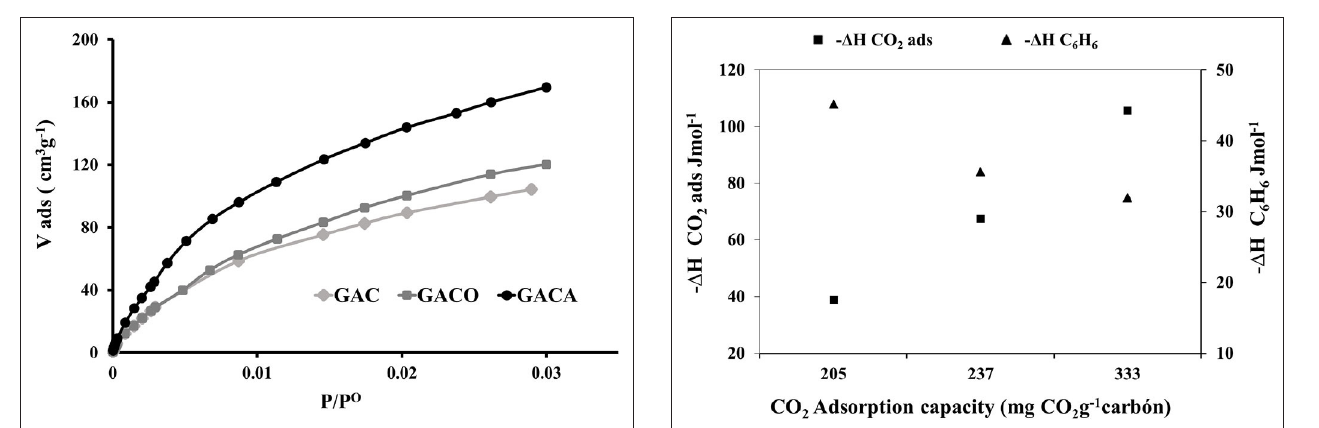
surface with surface groups that favor the affinity of the solid and the adsorbate.